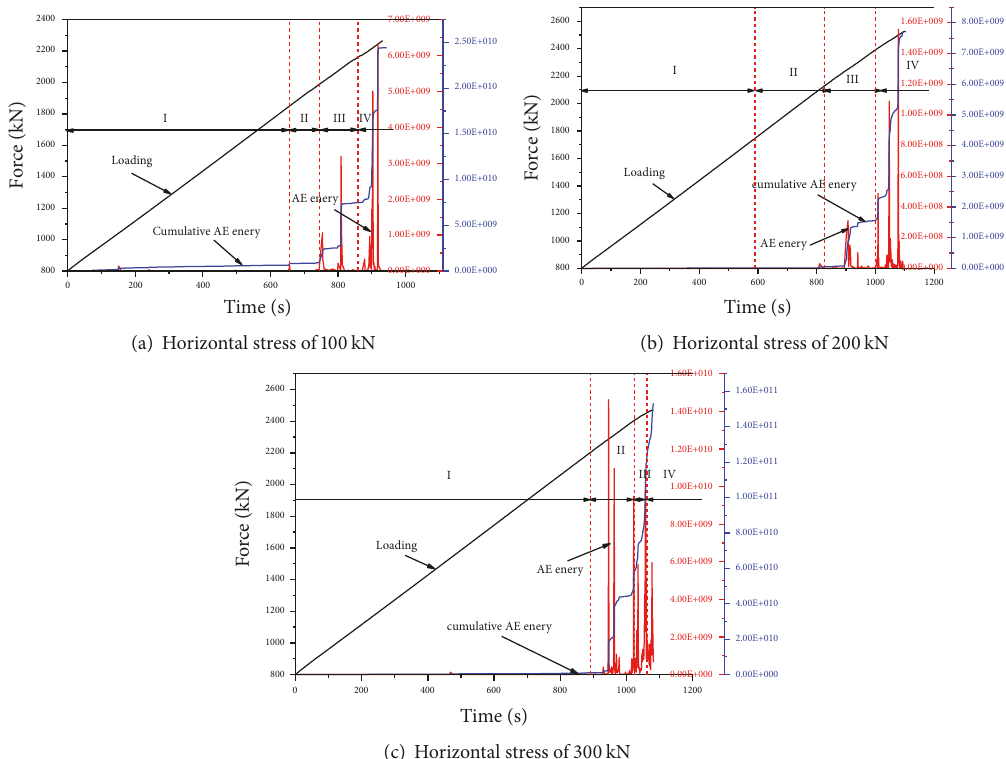
Figure8:LoadingcurvesandAEparameters;(I:pregnantrockburststage;II:smallparticleejectionstage;III:flakepeelingstage;IV:rockburst occurrence stage).